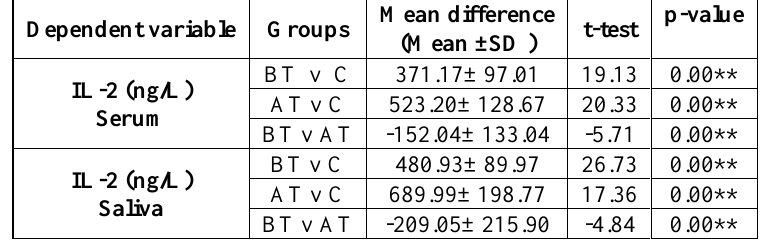
Table 2: Multiple comparison of serum and salivary IL-2 levels between the groups by Tukey's